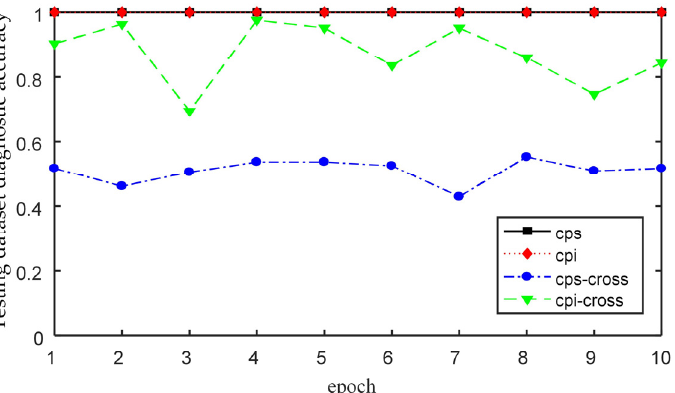
Figure 6. Test results of each test. (where cps is the diagnostic accuracy with parameter Convolution parameter sharing, cpi is the diagnostic accuracy with parameter Convolution parameter independence, cps-cross is the diagnostic accuracy with parameter cps and across working conditions, and cpi-cross is the diagnostic accuracy with parameter cpi and across working conditions). Table 6. Evaluation of test results for each test.